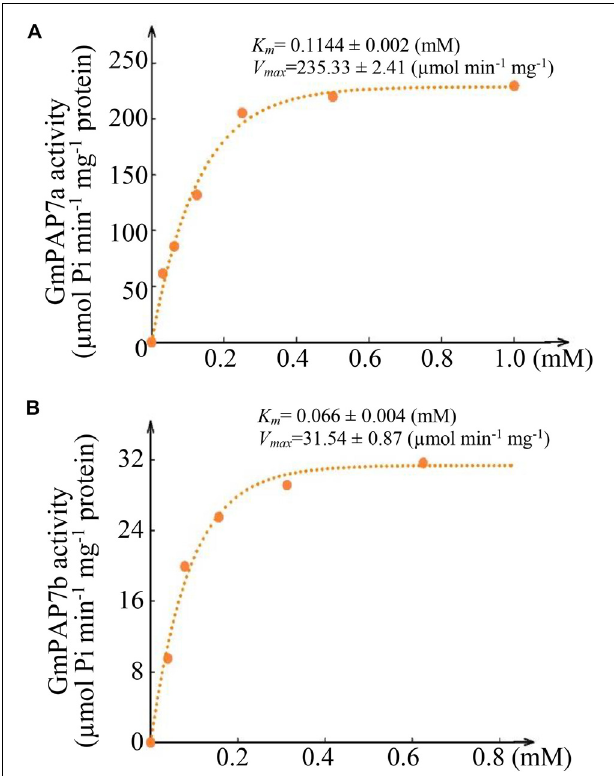
FIGURE 7 | Kinetic parameters of GmPAP7a and GmPAP7b against ATP. (A) Kinetic parameter of GmPAP7a. (B) Kinetic parameter of GmPAP7b. The K m and V max of GmPAP7a and GmPAP7b were calculated from Lineweaver–Burke plots of enzyme activities at different concentrations of ATP. The data are the means of three